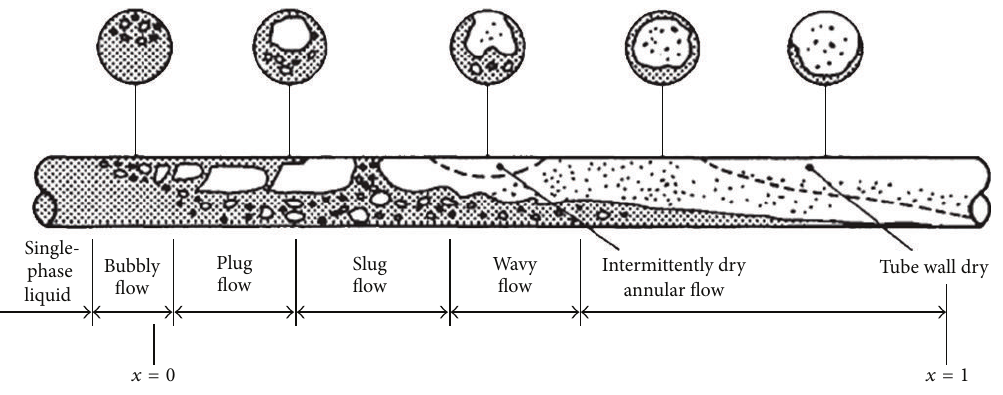
Figure 3: Flow patterns during evaporation in horizontal tube with uniform heat flux [10].